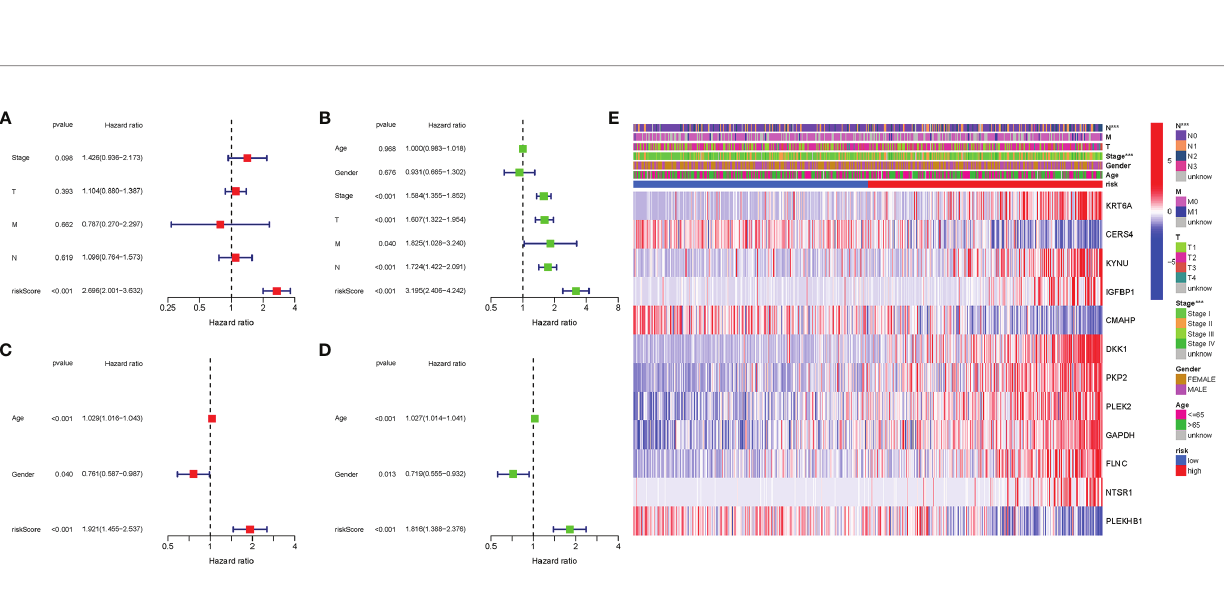
FIGURE 7 | Univariate and multivariate Cox regression analyses. (A) Multivariate analysis for TCGA cohort. (B) Univariate analysis for TCGA cohort (T, M, N, Stage: the degree of tumor differentiation). (C) Multivariate analysis for the GEO cohort. (D) Univariate analysis for the GEO cohort (Age, Gender). (E) Heatmap (green: low expression; red: high expression) for the connections between clinicopathologic features and the risk groups. ***P <